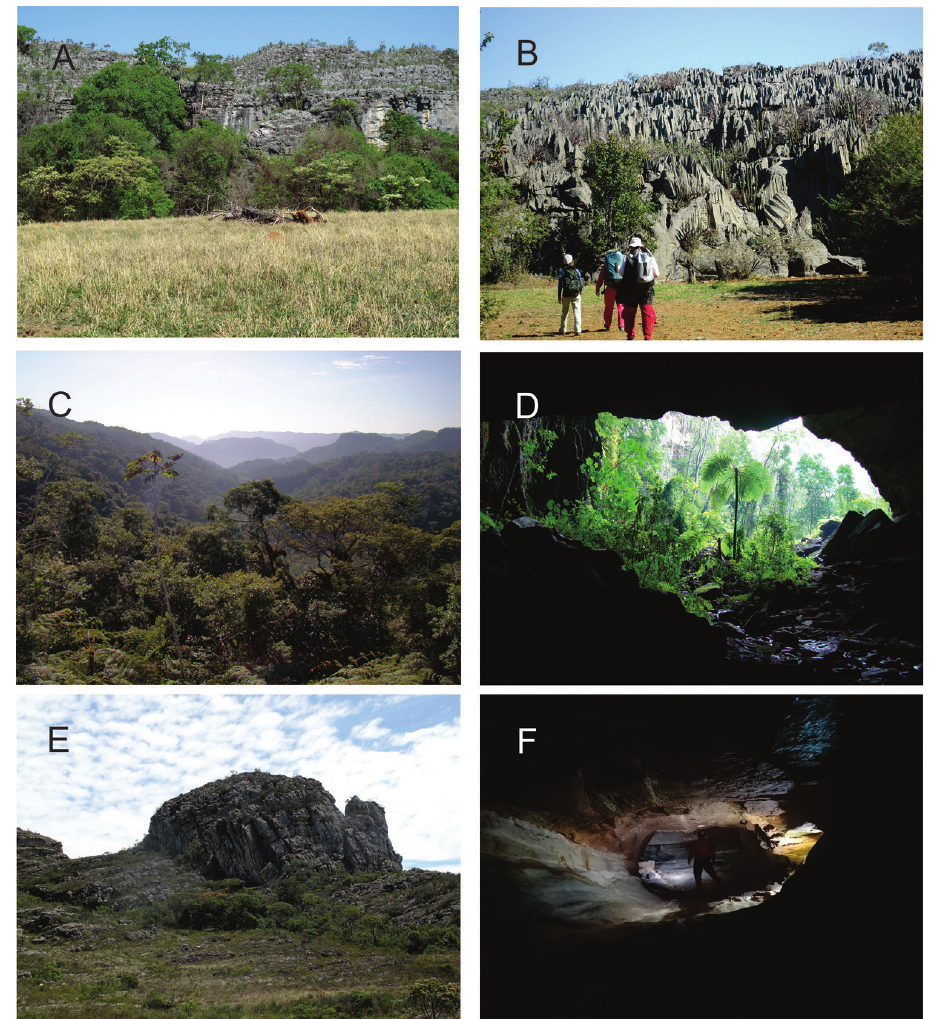
Figure 4. Outcrops and caves from Brazil with centipede records. A Limestone outcrops with pastures from Peruaçu region, Minas Gerais state. Cerrado (savannah-like vegetation) interspersed with Caatinga (xerophitic vegetation) (M.E. Bichuette) B Limestone outcrops with pastures from Serra do Ramalho, Bahia state. Caatinga (xerophitic vegetation) (M.E. Bichuette) C Atlantic Rainforest and limestone outcrops from Alto Ribeira, São Paulo state (M.E. Bichuette) D Alto Ribeira cave entrance, São Paulo state (M.E. Bichuette) E Quartizite outcrops with “Campo rupestre” vegetation from Diamantina, Minas Gerais state (M.E. Bichuette) F Sandstone cave from Igatu, Chapada Diamantina, Bahia state (E.C. Igual). system from the Alto Ribeira karst area (São Paulo) is the best-studied cave in Brazil, with systematic collections since the 1980s, and was second in centipede species count (Figure 5). These results reinforce the fact that multiple factors should be considered when discussing distribution, rarity, and ecological patterns in cave